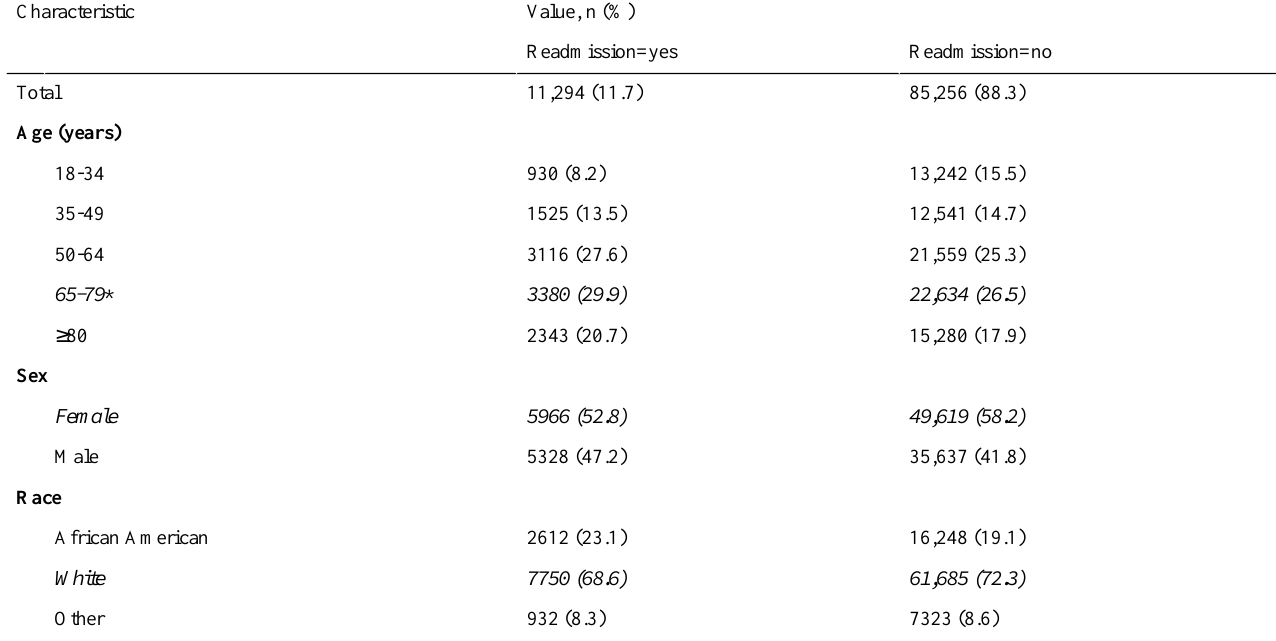
Table 2. Demographic information of the 96,550 patients included in the data set. The characteristics with the highest frequencies are indicated with italic